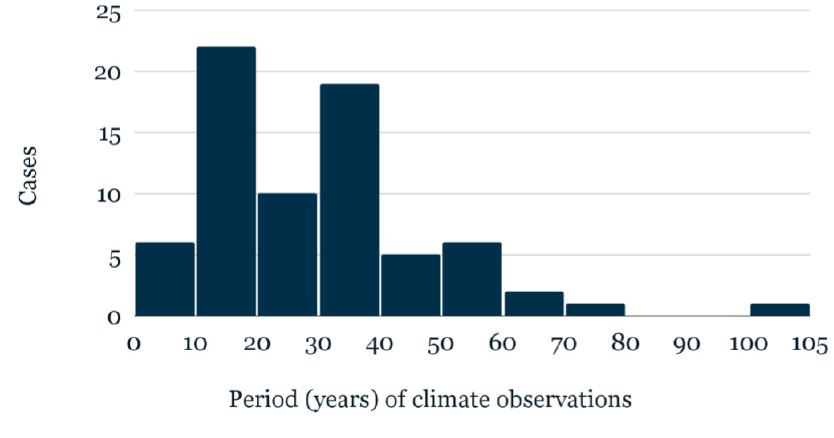
Figure 9. Histogram of climate observation periods.